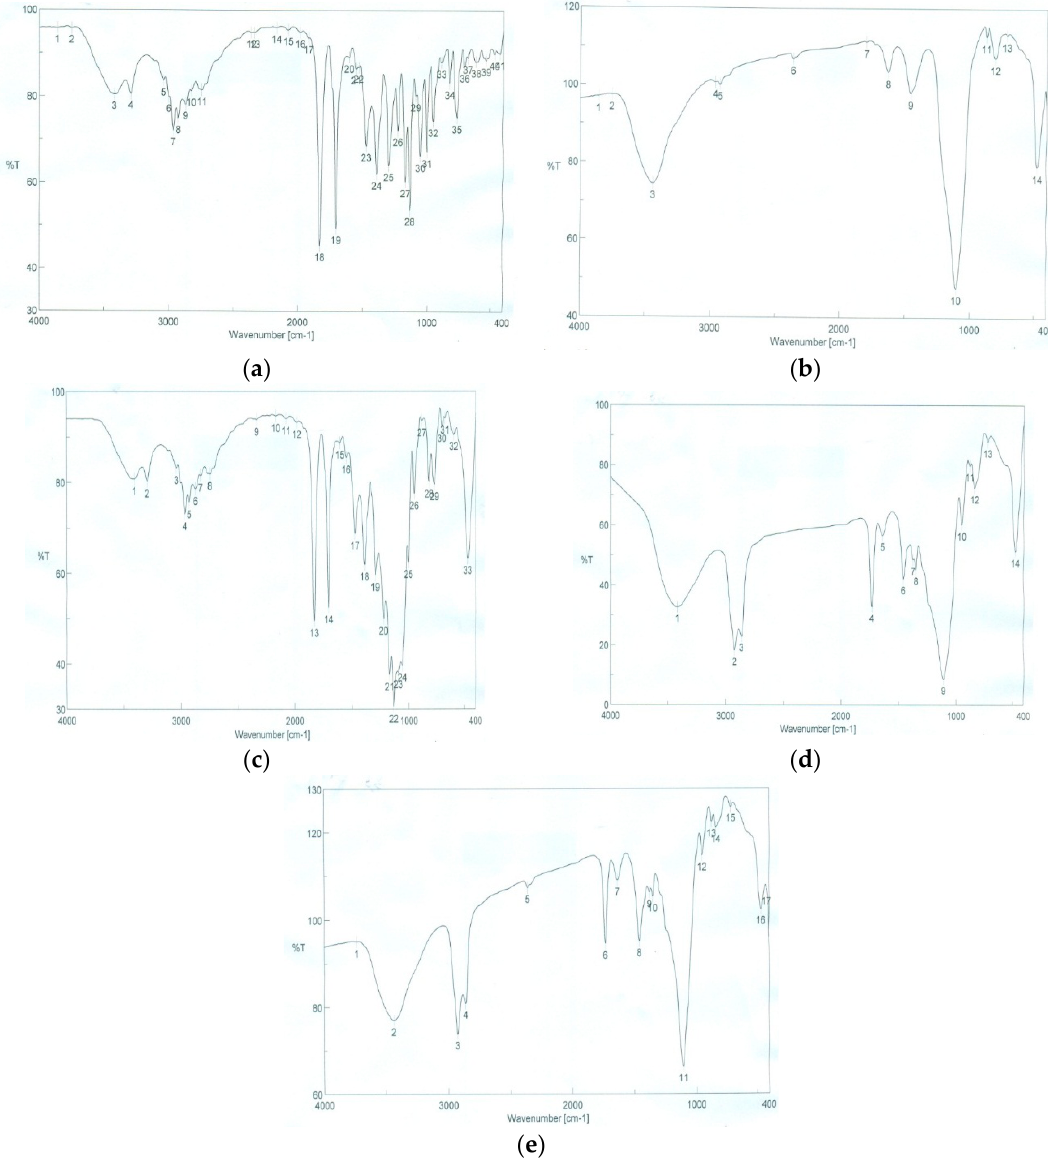
Figure 9. FTIR spectra of ( a ) Pure OLM; ( b ) Aerosil 200; ( c ) Physical mixture of OLM and Aerosil 200; ( d ) OLM S-SNEDDS formula (F3); ( e ) OLM S-SNEDDS formula (F4).